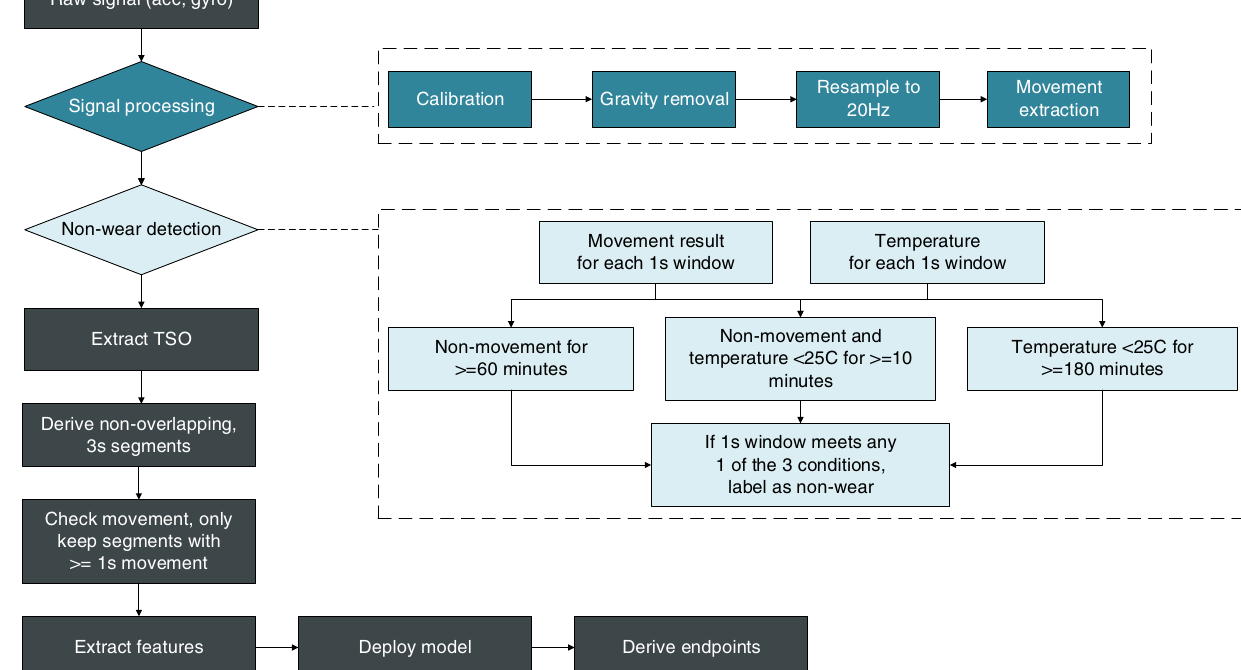
Fig. 8 Model deployment. Flowchart of model